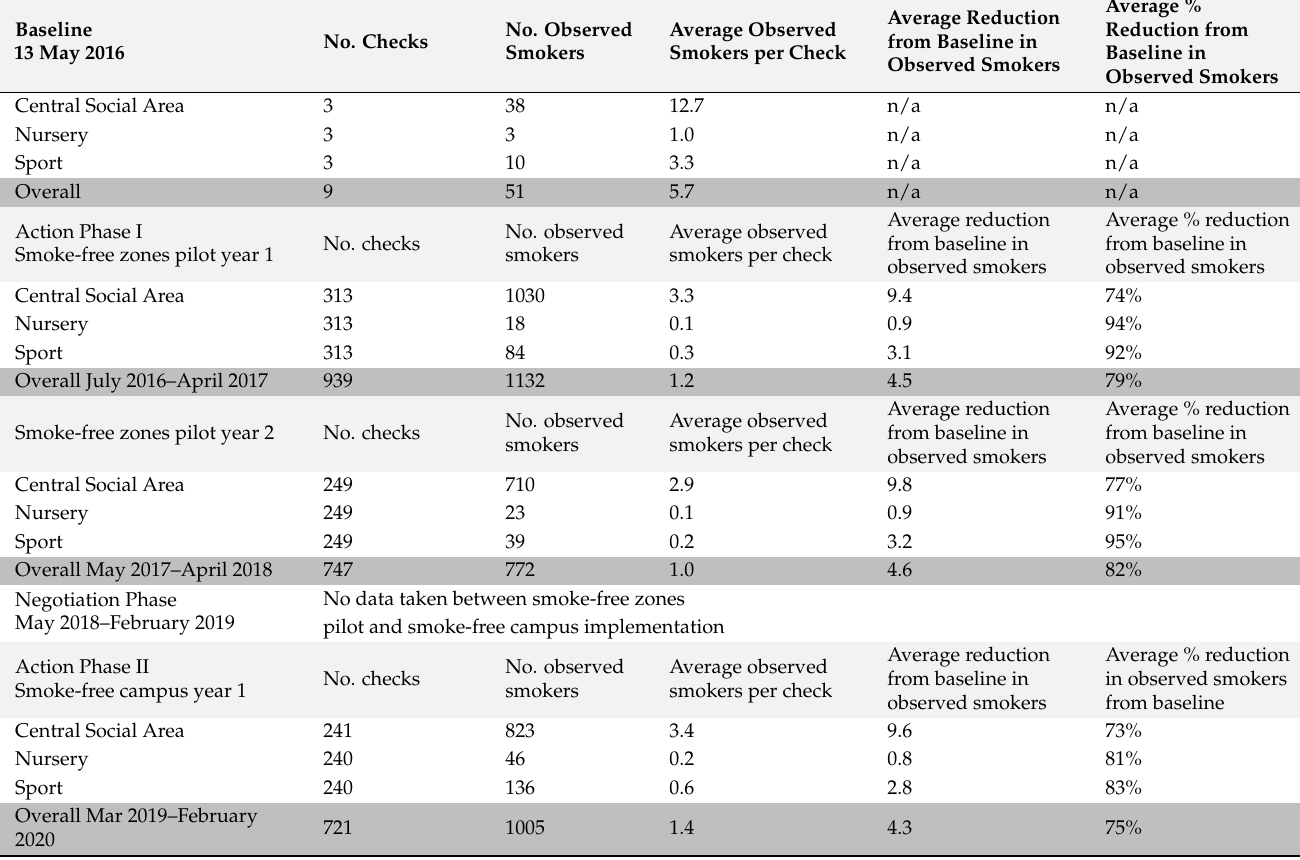
Footer: Headings and totals presented in shaded